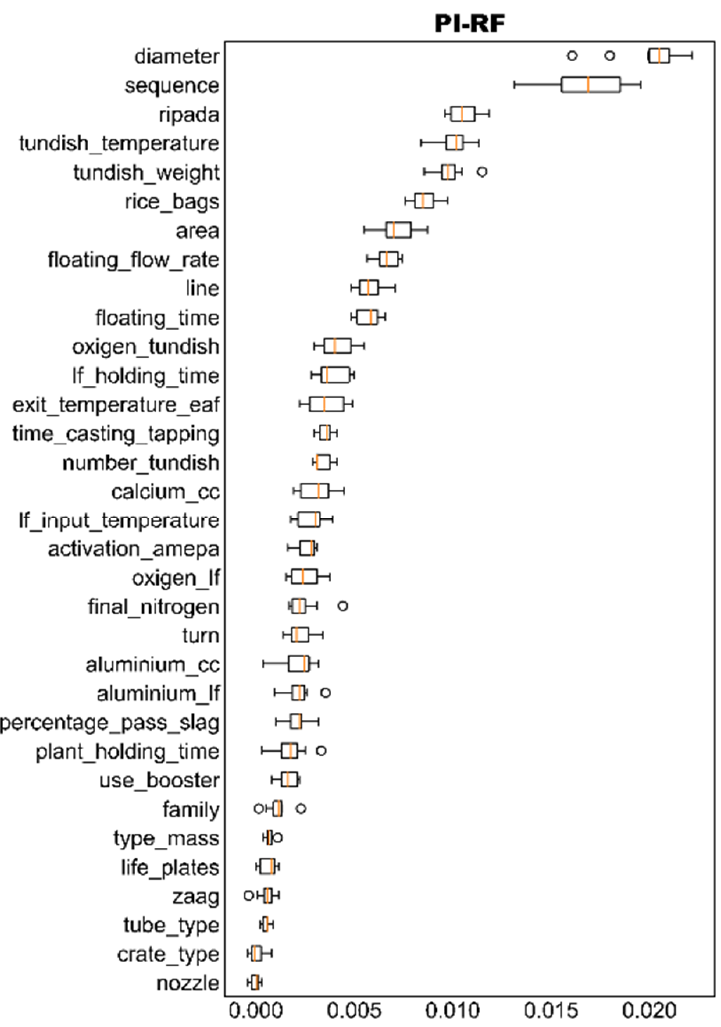
11 of 19 Figure 4. The histograms represent the probability provided by the optimized RF model of the 500 observations of the test set with the highest value of the K3 index and of the 500 observations with the lowest value of the K3 index, respectively, of belonging to category “1”. 3.2.2. Importance of the Features A first step to interpret the outcome of the ML analysis is to find out which features